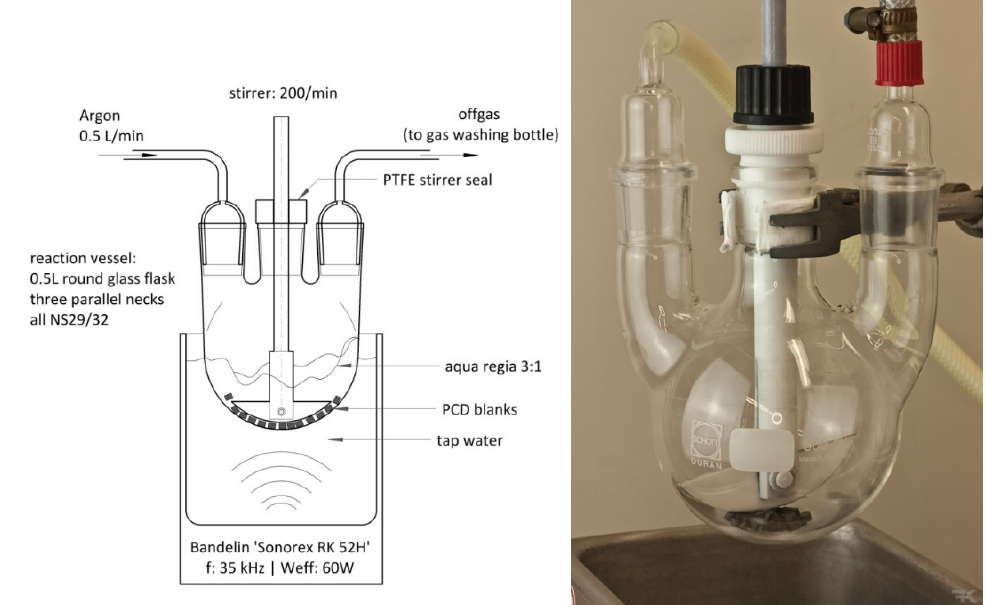
Figure 4. The description and picture of the leaching reactor.